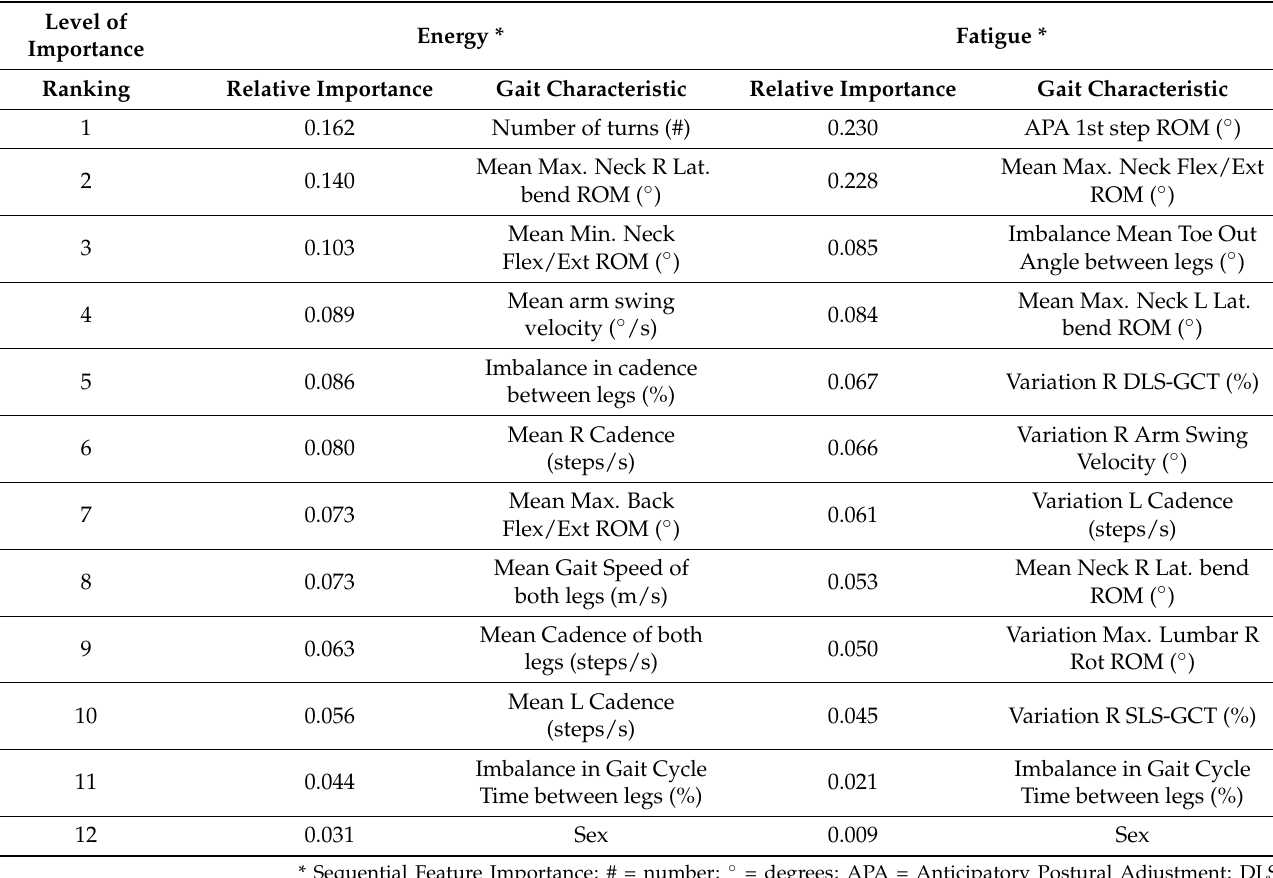
Table 3. Top 12 most important features for the best regressor